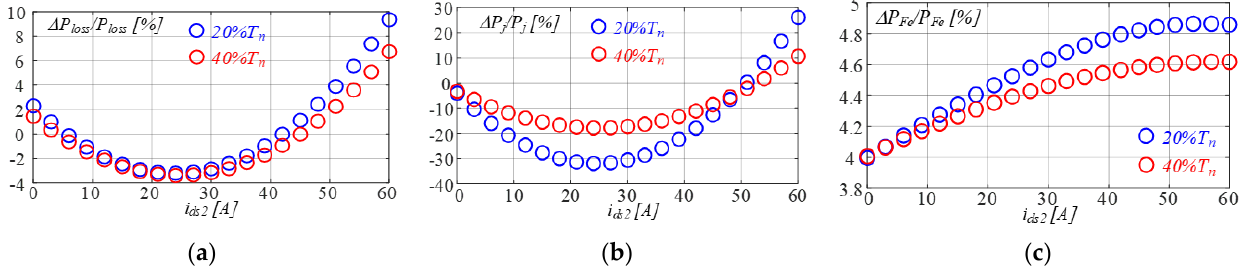
Figure 9. ( a ) Total loss variation in p.u. ∆ P loss , ( b ) joule losses variation in p.u. ∆ P j , and ( c ) iron losses variation in p.u. ∆ P Fe , vs. i ds2 , computed at 20% and 40% of rated torque T n . Joule P J and iron P Fe losses referring to the single-winding IM are the points displayed in the three graphs at i ds2 = 0.